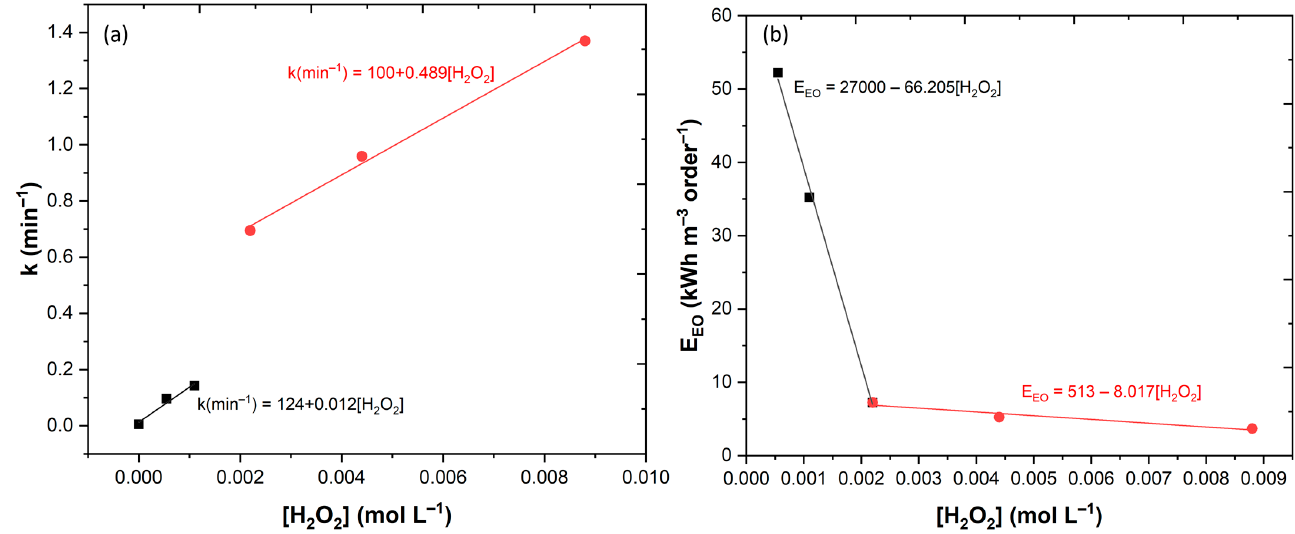
Figure 5. Outcome of several concentrations of H 2 O 2 in CA degradation by the UV-A-Fenton pro- cess; ( a ) dependence on the kinetic constant rates; ( b ) electric energy per order ( E EO ).